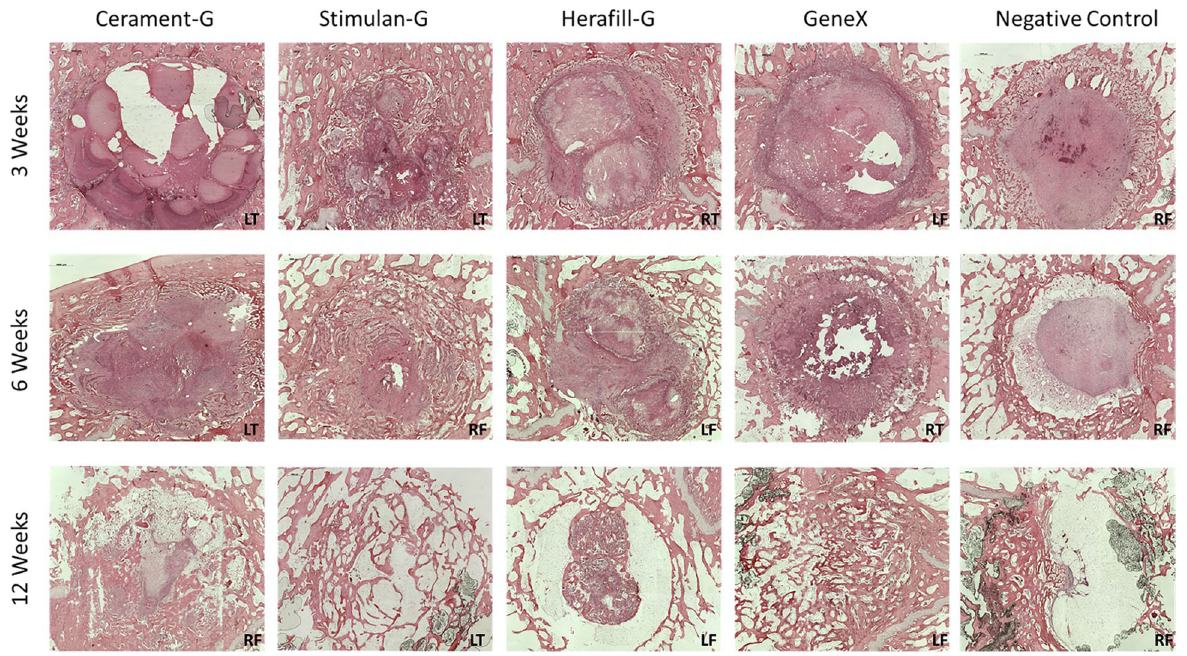
Fig. 5 Histology of Bone after exposure to implant materials. Repre- sentative images of the histology from the right femur (RF) or left femur (LF) of sheep implanted with each of the test materials